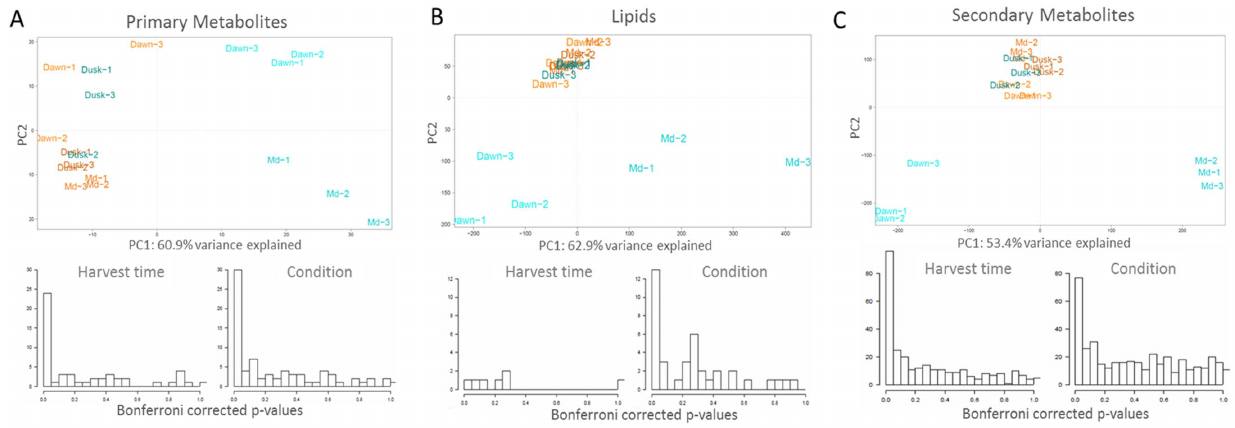
Figure 2. Principal Component Analysis (PCA) and ANOVA for metabolomic analysis of leaf samples from control and watered plants. (a) PCA (upper part) and ANOVA (lower part) for primary metabolites. (b) PCA (upper part) and ANOVA (lower part) for complex lipids. (c) PCA (upper part) and ANOVA (lower part) for secondary metabolites. Shown are always three independent samples per time point (dawn (1 hour post dawn/after watering), midday (6 hours after dawn/after watering) and pre-dusk (12 hours after dawn/after watering). Watered samples are shown in blue, non-watered in red. The lower part shows the results of a Bonferroni corrected ANOVA displaying the influence of treatment (watering) for all samples and of harvesting time for primary and secondary metabolites.